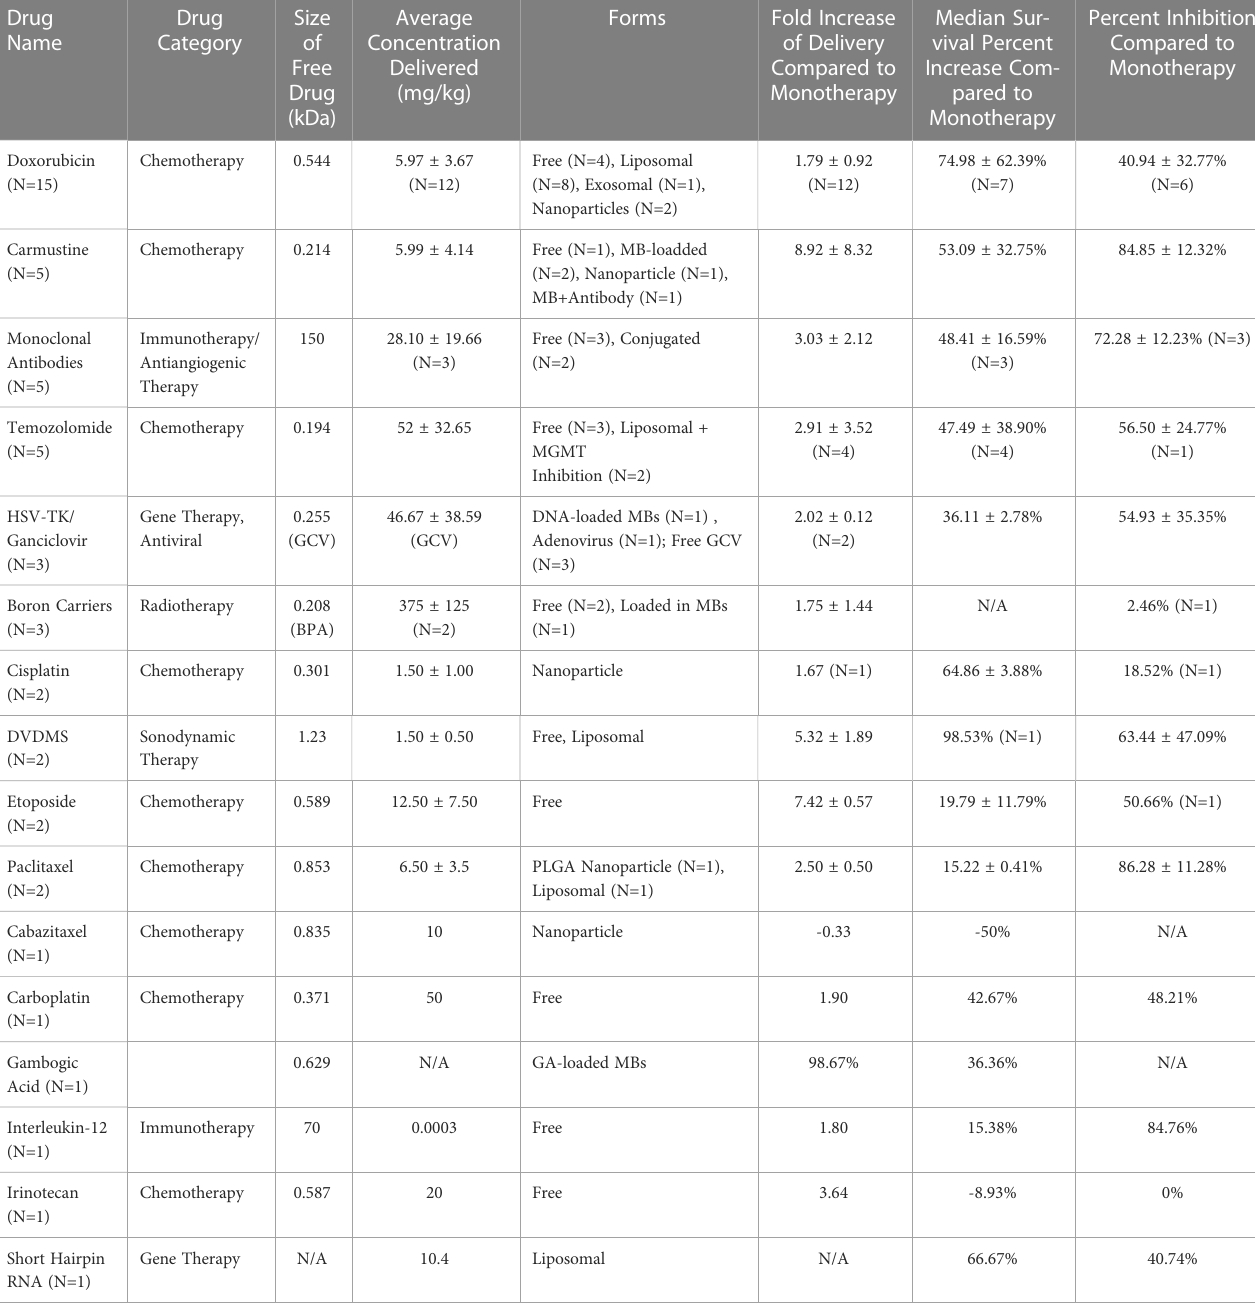
TABLE 2 Therapeutic compounds tested with FUS-mediated BBB opening in vivo for the treatment of